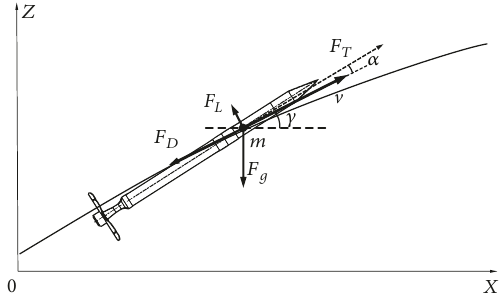
Figure 4: ICP-89 imitator outline in 2D space with essential variables describing its